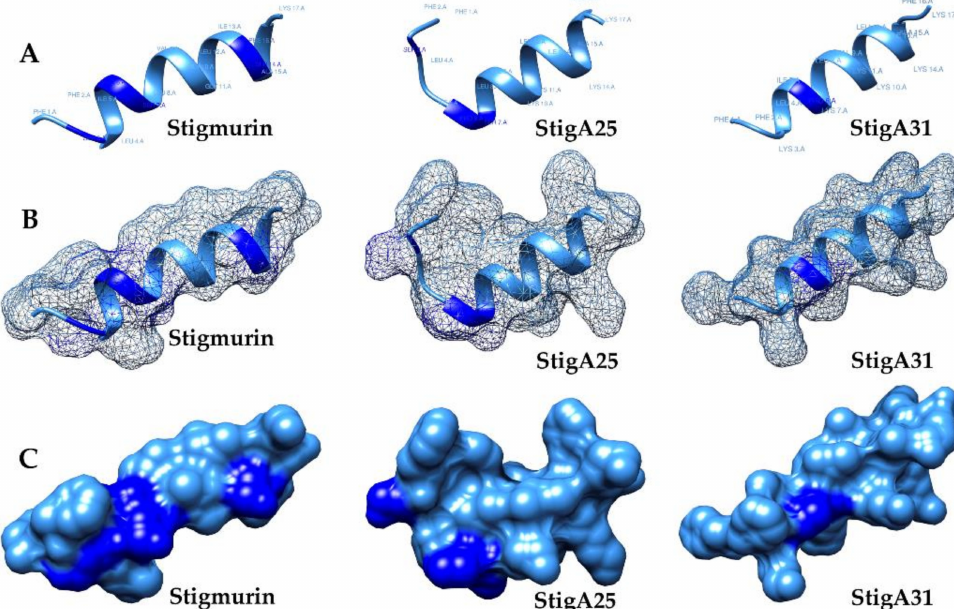
Figure 1. Theoretical tridimensional structure by AIDA using UCSF Chimera software for the peptides Stigmurin, StigA25, and StigA31. In ( A ) peptides in surface model, ( B ) mesh model, and ( C ) electrostatic surface. Light blue and dark blue represent hydrophobic and hydrophilic regions,